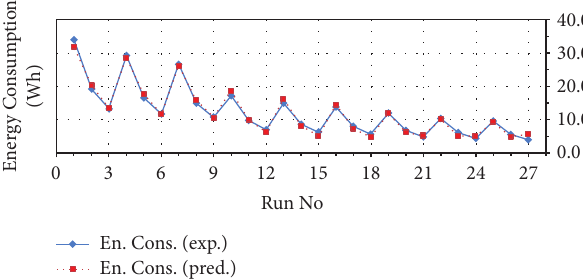
Figure 11: Comparison between predicted and measured values for energy